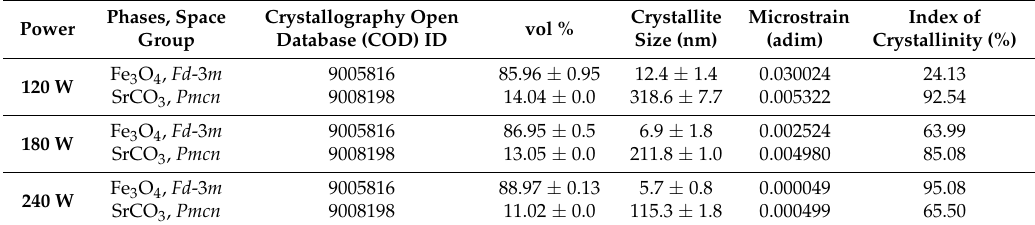
Table 1. Data from the Rietveld refinements of the X-ray diffraction patterns and index of crystallinity of the powders obtained at 120, 180, and 240 W without heat treatment.